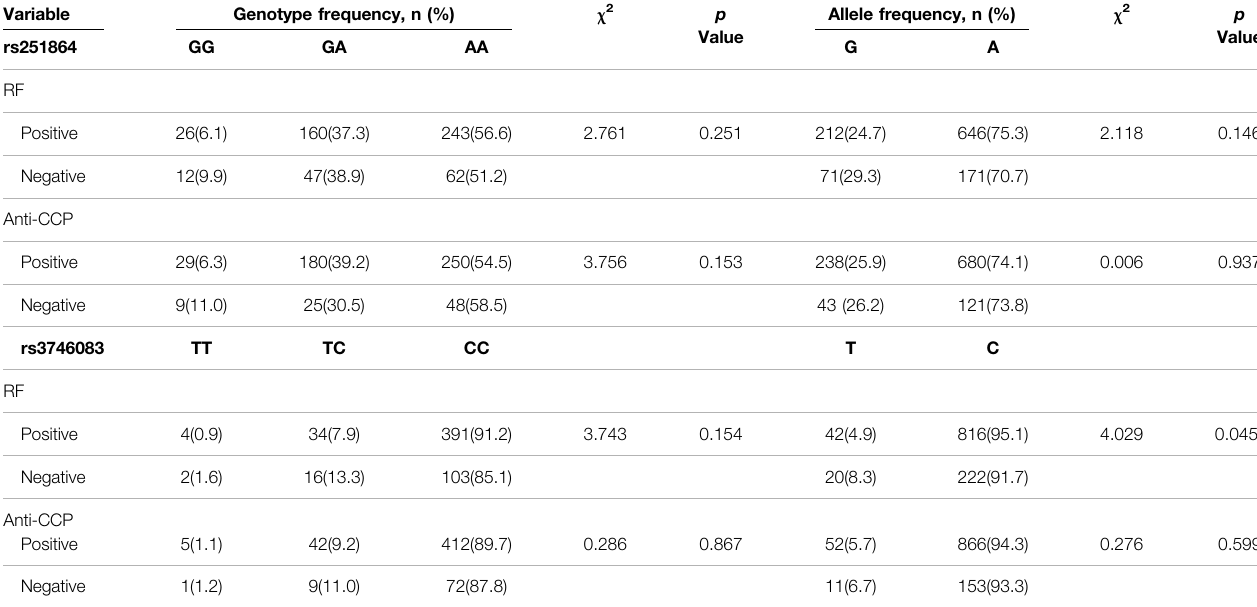
TABLE 3 | Association of TTP gene polymorphisms with auto-antibody pro fi les in patients with RA. Variable Genotype frequency, n (%)